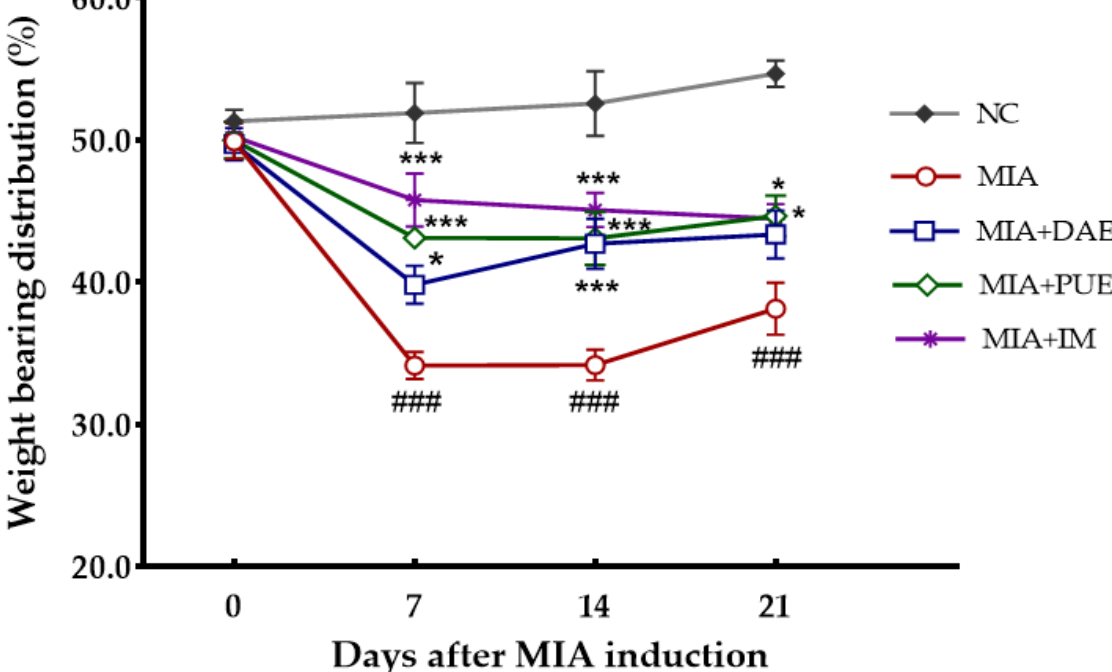
Figure 2. Effects of DAE and PUE on hind paw weight-bearing distribution in MIA-induced OA rats. After the injection of MIA, weight-bearing distribution was measured using an incapacitance tester once per week for 21 days. Data are expressed as the mean ± SEM ( n = 7 per group). NC, untreated; MIA, only MIA-induced; MIA + DAE, MIA-induced and DAE-treated; MIA + PUE, MIA-induced and PUE-treated; MIA + IM, MIA-induced and IM-treated rats. ### p < 0.001 indicates statistically significant differences between the NC and MIA-induced control rats. * p < 0.05, *** p < 0.001 indicate statistically significant differences between the MIA-control rats and the DAE-, PUE-, or IM-treated rats.